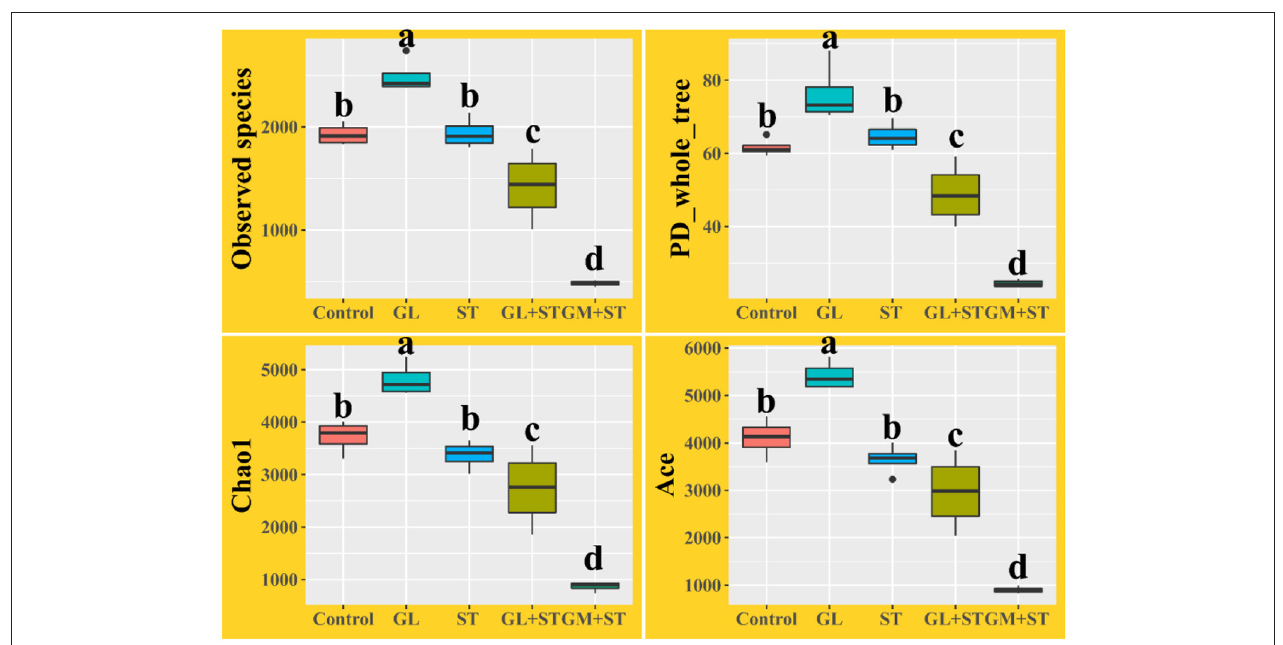
FIGURE 6 | Alpha diversity analysis of intestinal microbiota in different groups ( n = 4/group). Different lowercase letters indicate a significant difference ( P < 0.05).